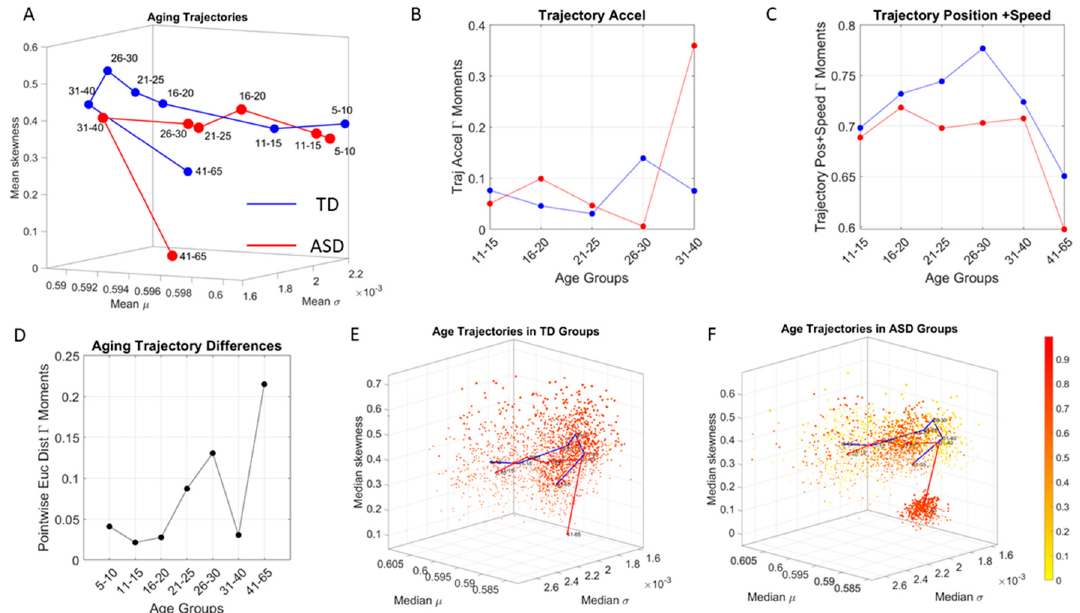
Figure 8. Aging trajectories captured cross-sectionally in each cohort ( A ) Dots denote the location of the mean values of the empirically estimated Gamma moments of each age-group and group type. These show different trajectories with non-uniform changes in ASD during the early years and large departure from normative data from age-match neurotypically developing controls (TD) throughout aging, particularly after 41 years of age. Notice that the rates of change of the shifts in the points are different in ASD. They do not change as regularly as the controls during the first 15 years. ( B ) The acceleration of the trajectory shows the differences in the rates of change of the shifts in the averaged Gamma moments for each cohort, with inflection points around 26–30 years of age that take the systems into different directions. ( C ) The position plus each increment (trajectory velocity) is also accumulated to examine the trajectory over time. This reveals differences that become more pronounced after 20 years of age and decrease by 40, right before the largest departure from normative data that separates the oldest ASD cohort form the age-matched TD. ( D ) The pointwise difference between the two trajectories reveals a large change after 20 and an inflection point by 40, right before the accelerated change of the 41–65 ASD group. ( E ) The trajectories are embedded in the scatter to give a sense of the differences in relation to the full TD cloud. ( F ) The cloud of ASD with the embedded trajectories highlights the large departure of the 41–65 group from the normative trajectory.